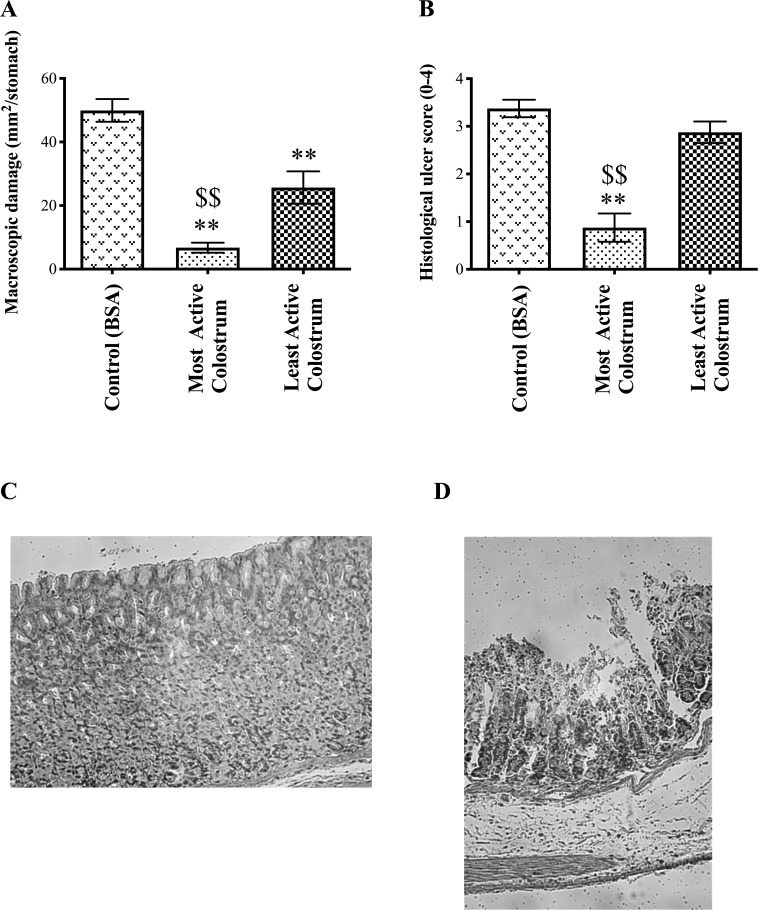
Effect of colostrum samples on NSAID-induced gastric injury.Rats received 2ml oral gavage of control (BSA), or the most active or least active colostrum samples determined from Fig 1A (colostrum samples numbered 1 and 20), 30 minutes prior to receiving indomethacin (20mg/kg, sc), and 3h of restraint. Amount of macroscopic (A) and microscopic (B) damage was subsequently assessed. Microscopic scoring scheme described in [3]. Stomachs from animals that received NSAID + most active colostrum had essentially normal histology (C) whereas animals receiving NSAID + least active colostrum continued to show multiple erosions (D). Results expressed as mean +/- SEM of 8 animals per group. ** signifies p< 0.01 vs control and $ $ signifies p< 0.01 of best sample vs worst.